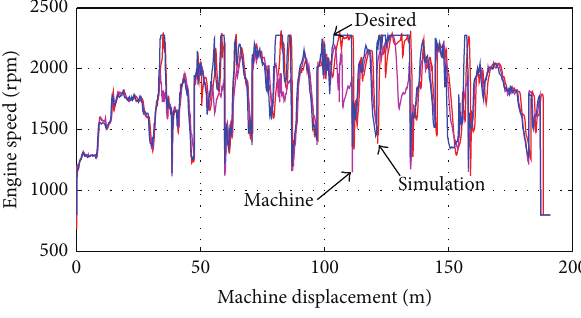
Figure 12: Validation engine speed.